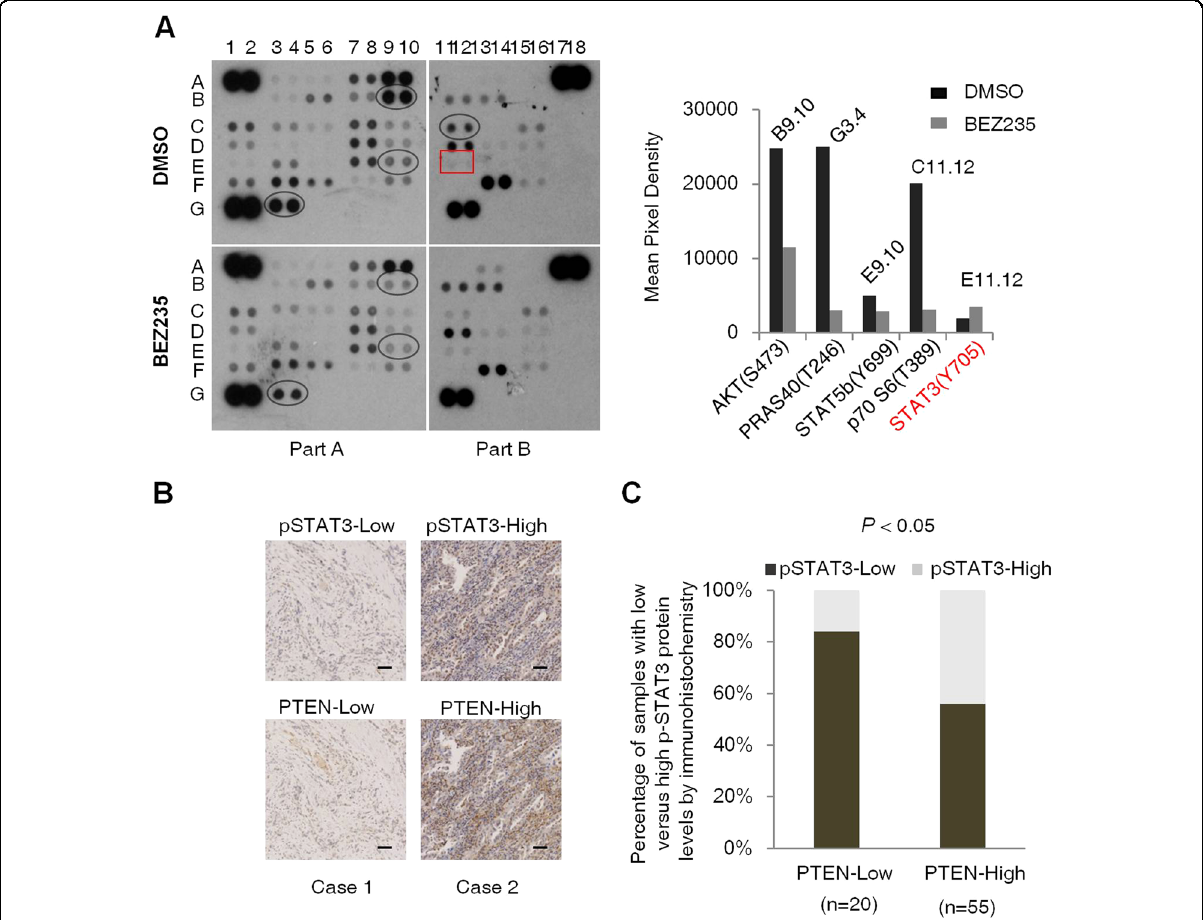
Fig. 1 STAT3 activity is inhibited in PTEN-de fi cient cancer cells. A Phosphokinase antibody array blots using lysates of control and BEZ235- treated HGC-27 cells (left panel) and the changes in the expression levels of PI3K/AKT/mTOR signaling molecules and p-STAT3 activity before and after BEZ235 treatment (right panel). B Representative immunohistochemistry (IHC) images showing in situ PTEN and p-STAT3 expression in two patients with gastric cancer. Scale bars, 50 µm. C Correlation between PTEN and p-STAT3 expression in 75 gastric cancer patients. P < 0.05, calculated by Mann – Whitney